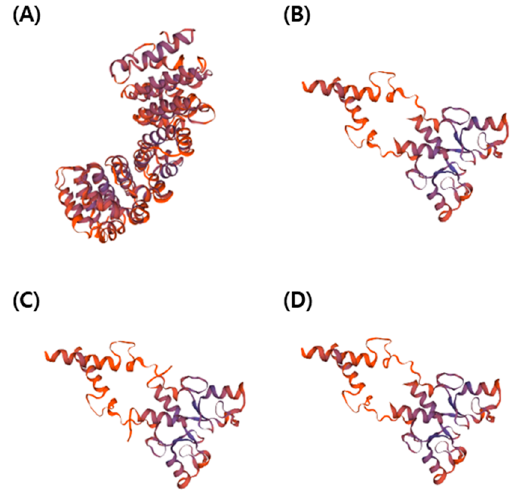
Figure 11. 3D protein structure based on amino acid sequences of the gene-edited PUB7-GE. ( A ) OsPUB7 wild type. ( B ) PUB7-GE K343-7-5. ( C ) PUB7-GE K343-8-1. ( D ) PUB7-GE K343-17-8.